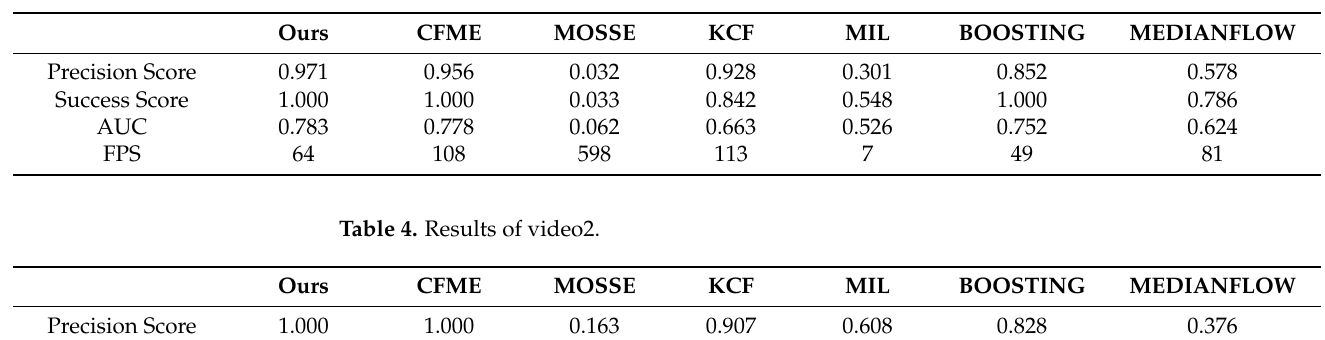
Table 3. Results of video1.